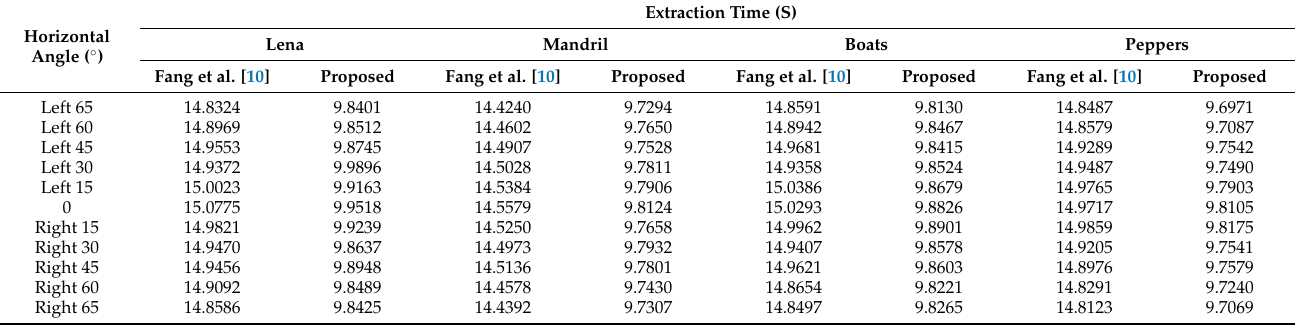
Table 11. Watermark extraction time at different horizontal angles.